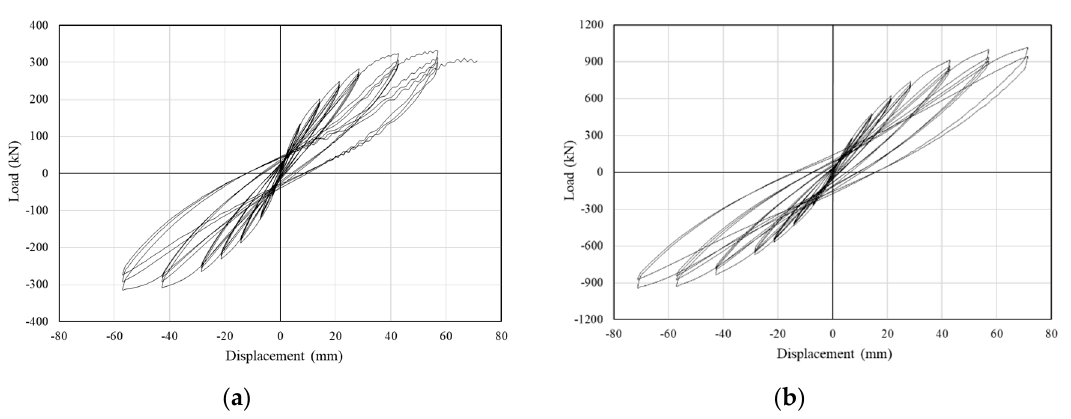
Figure 8. Load–displacement curves: ( a ) non-seismic reinforced control specimen (NRC) and ( b ) WCFST.